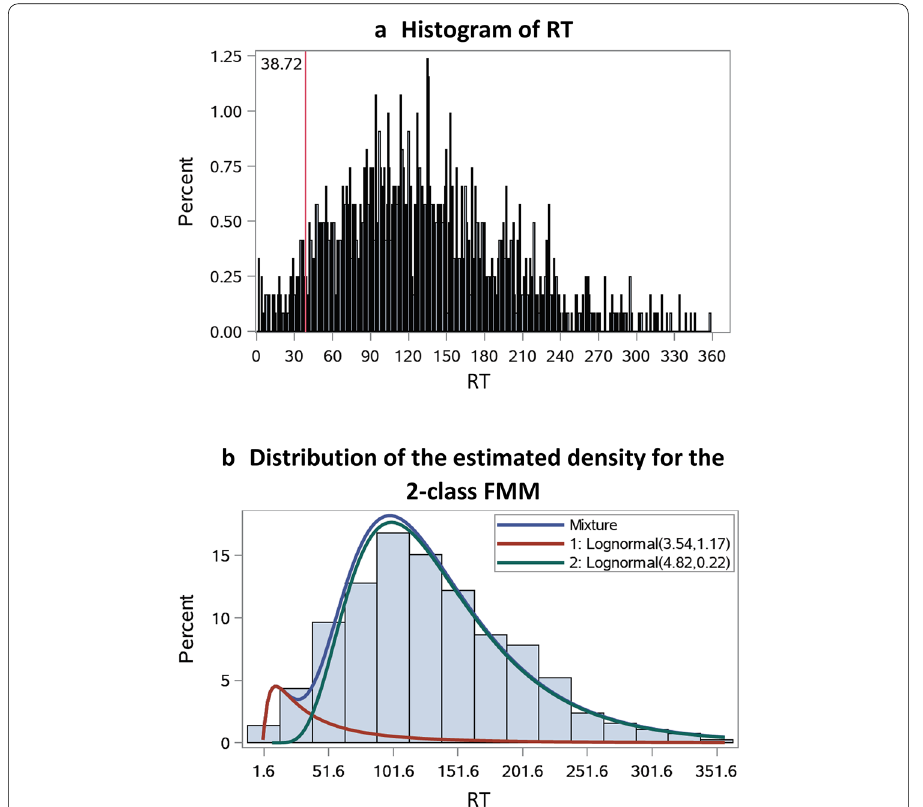
Fig. 1 RT (trimmed at 99%) distribution of item S131Q02 for the students who were administered the item in the 4th cluster position. a : Histogram of RT distribution (1 s intervals); the red vertical line corresponds to the threshold estimated by means of the FMM model. b : Densities estimated in the 2-class FMM